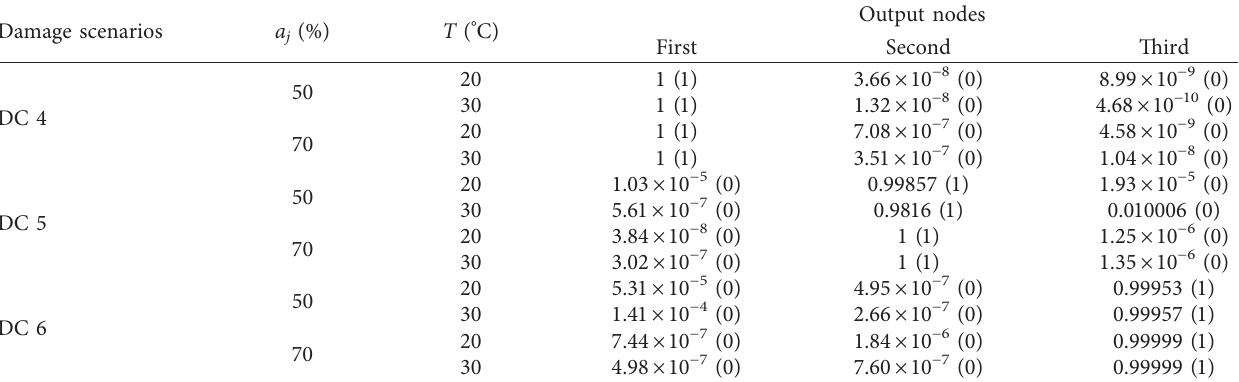
Table 6: The identification results of damage locations when two braces are damaged.